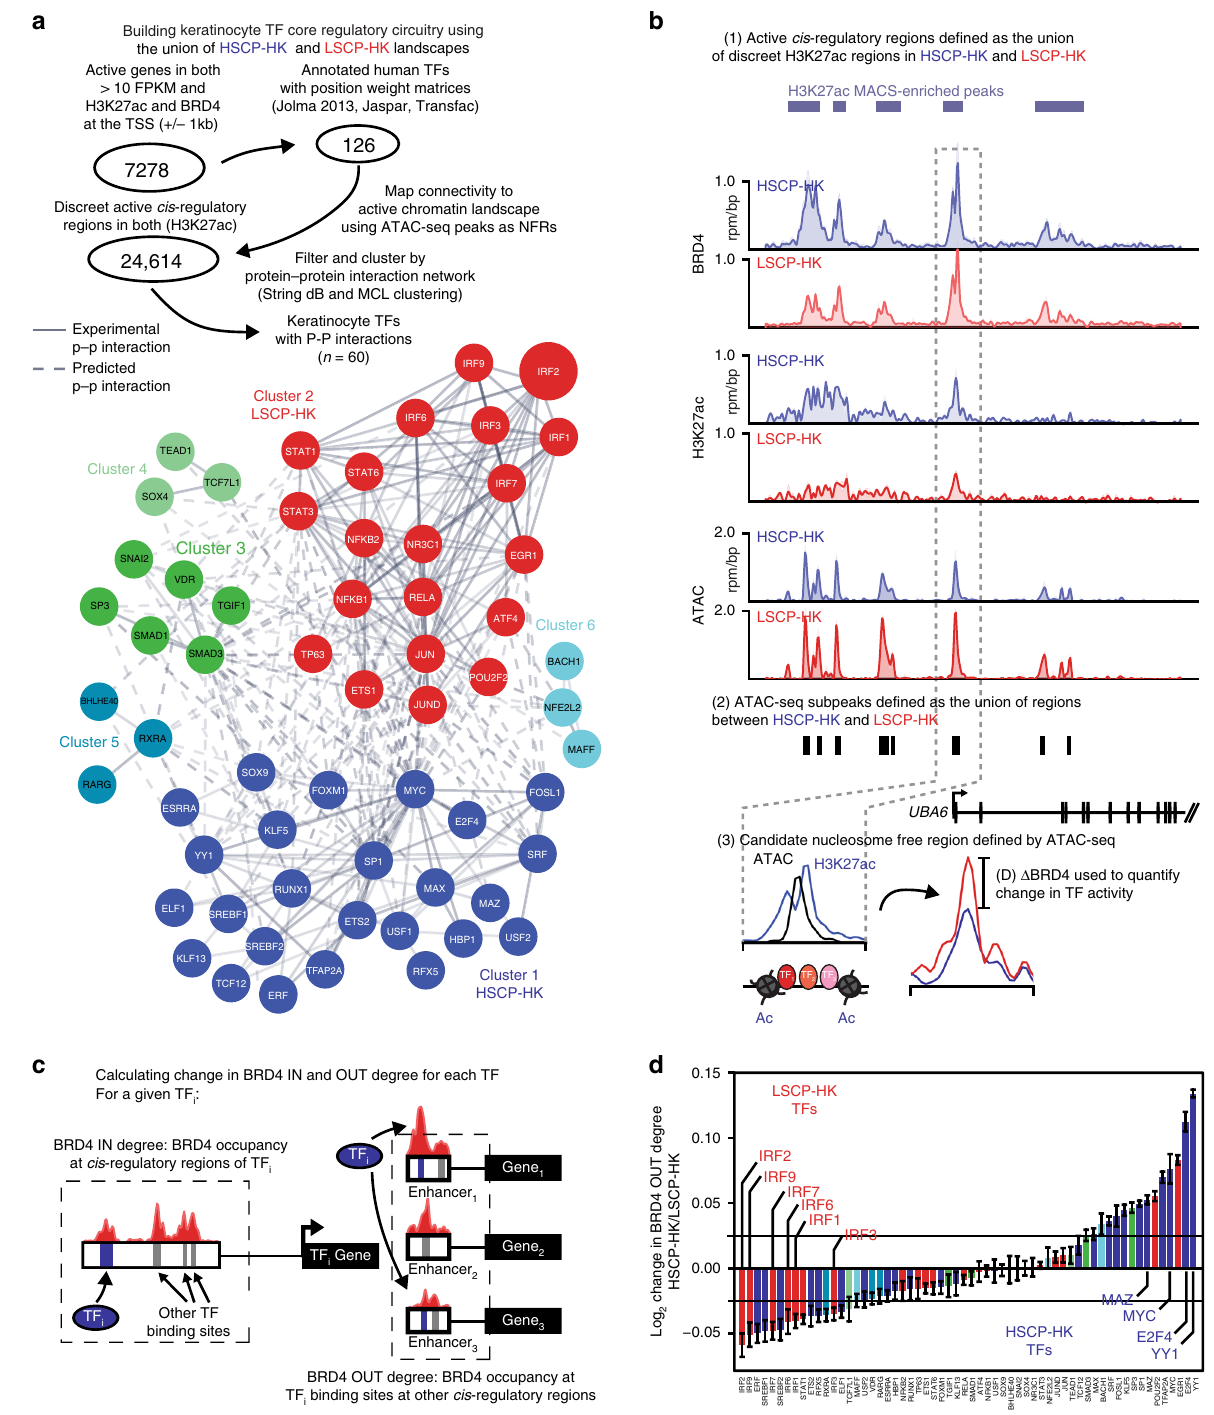
Calculating change in BRD4 IN and OUT degree for each TF For a given TF i :